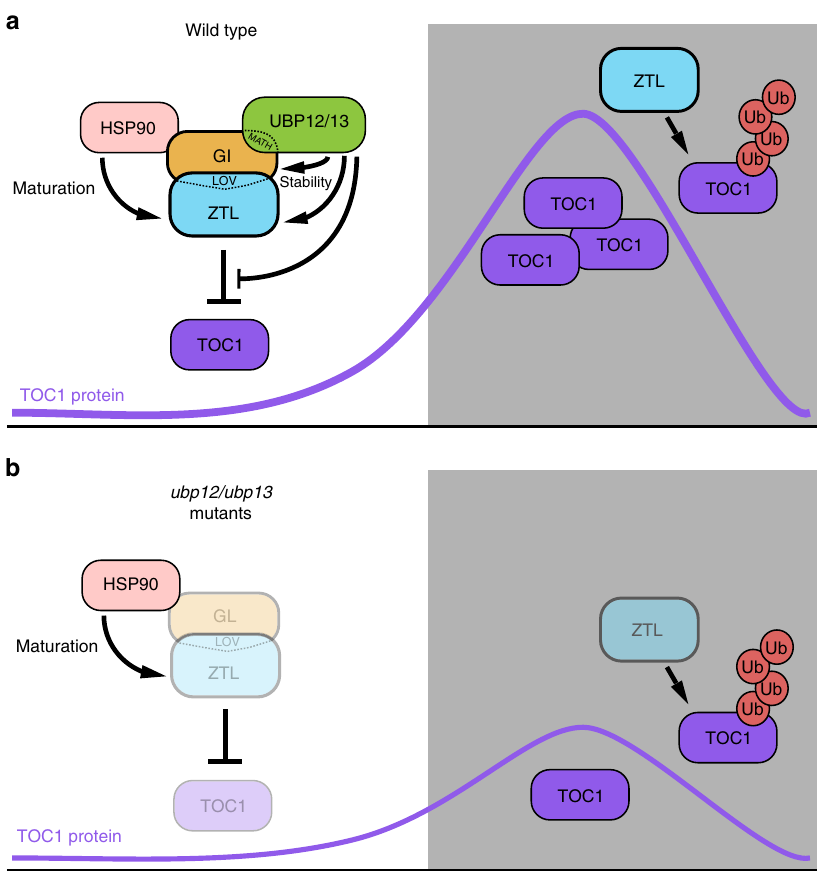
Fig. 4 The proposed model for UBP12/UBP13 regulation of ZTL. a In the light, GI interacts with ZTL and acts as a co-chaperone, recruiting HSP90 to facilitate folding and maturation of the ZTL protein. Additionally, GI physically bridges an interaction between ZTL and UBP12 or UBP13. UBP12 or UBP13 stabilize the GI-ZTL protein complex before dusk. In the dark, GI dissociates from ZTL, and ZTL mediates ubiquitylation and degradation of the TOC1 protein. b Loss of UBP12 or UBP13 causes instability of ZTL and GI. Interestingly, the TOC1 protein levels are also reduced by loss of UBP12 or UBP13 , mimicking the gi loss-of-function